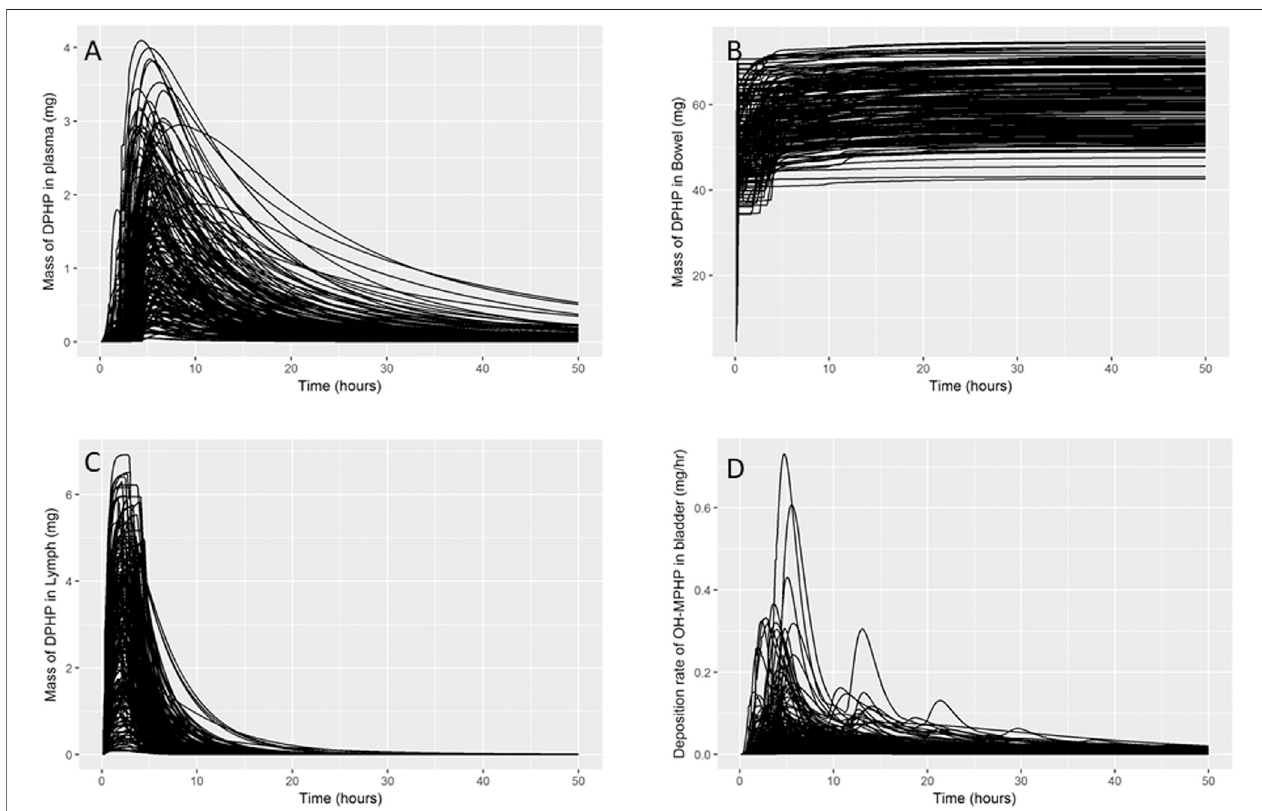
FIGURE 4 | Uncertainty analysis. Variability in the mass of DPHP in plasma (mg) (A) , bowel (mg) (B) and lymph (mg) (C) and variability in predicted rates of elimination of OH-MPHP in urine (mg/hr) (D) .